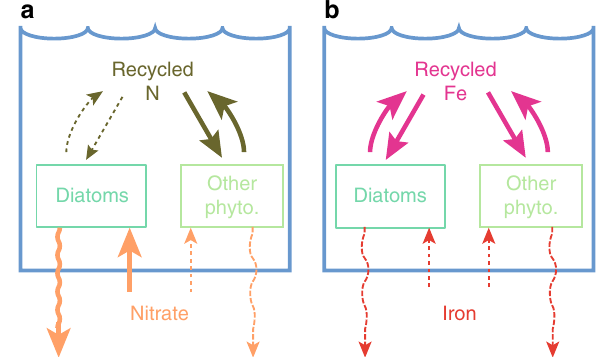
Fig. 3 Distinct iron and nitrogen cycling pathways and their affect on nitrate consumption. Conceptual models of a nitrogen (N) and b iron (Fe) transformation pathways in the eastern equatorial Paci fi c, where nutrient consumption is shown by a straight arrow, nutrient regeneration by a curved arrow, and wavy arrows denote export. Arrow size denotes relative fl ux size, and dashed arrows are very small fl uxes (see text for details). Other phyto. refers to non-diatom phytoplankton, including autotrophic fl agellates and picoplankton 25 , which primarily meet their N requirements with recycled N 21 (see “ Methods ” ). The preferential regeneration of iron relative to nitrogen predicts a higher export of nitrogen relative to